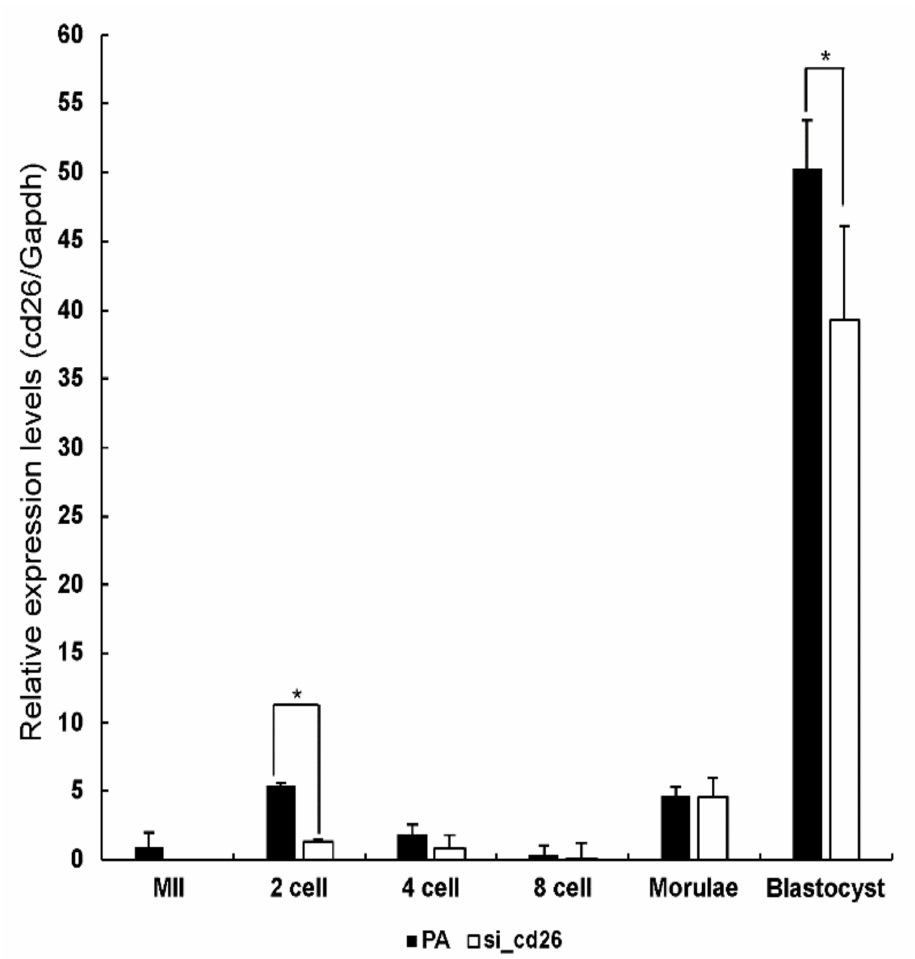
Figure 1. Relative abundance of cd26 transcripts in uninjected (PA) and siRNA-injected (si_cd26) porcine embryos. MII oocyte ( n = 250), two-cell (parthenogenetically activated (PA), n = 200; siRNA, n = 195), four-cell (PA, n = 151; siRNA, n = 162), eight-cell (PA, n = 155; siRNA, n = 172), morula (PA, n = 50; siRNA, n = 59), and blastocyst stages (PA, n = 98; siRNA, n = 115). * p < 0.05, from the one-way ANOVA, followed by t -test ( p < 0.05). Data are expressed as mean ±